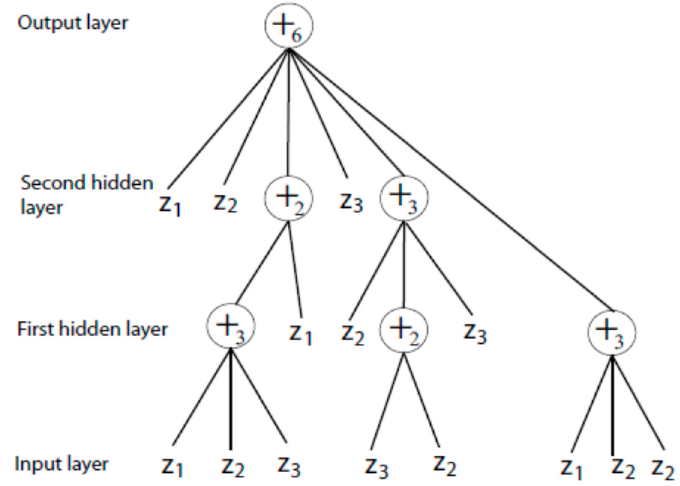
Figure 17. A typical CVFNT model with function set F = { + 2 , + 3 , + 4 , + 5 , + 6 } , and terminal instruction set T = { z 1 , z 2 , z 3 }